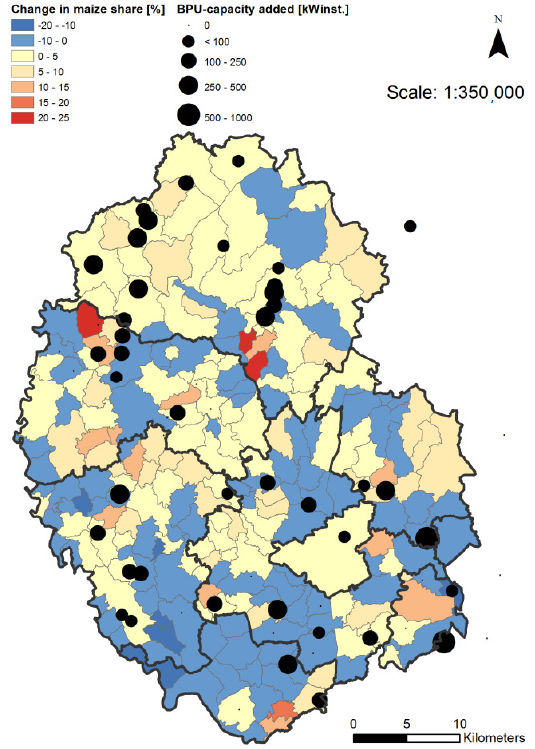
Figure 5. Representation of the changes in silage maize cultivation and the installed capacity of biogas producing units (BPU) from 2009 to